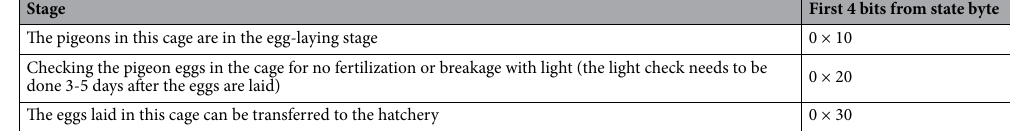
Table 2. Relationship between the pigeon cage and first 4 bits from State Byte.